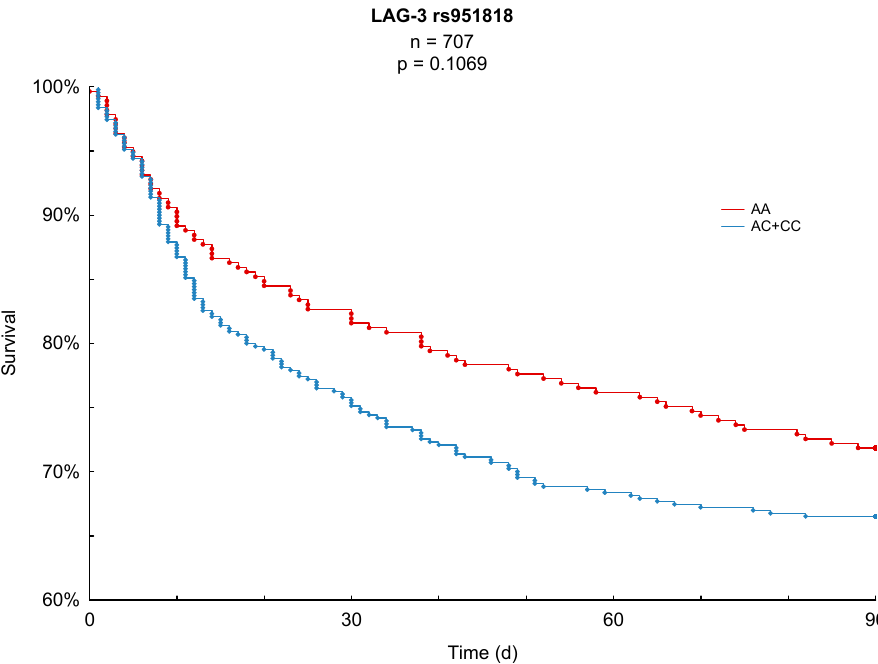
Figure 2. Kaplan–Meier 90 ‐ day survival analysis with respect to the LAG ‐ 3 rs951818 SNP.